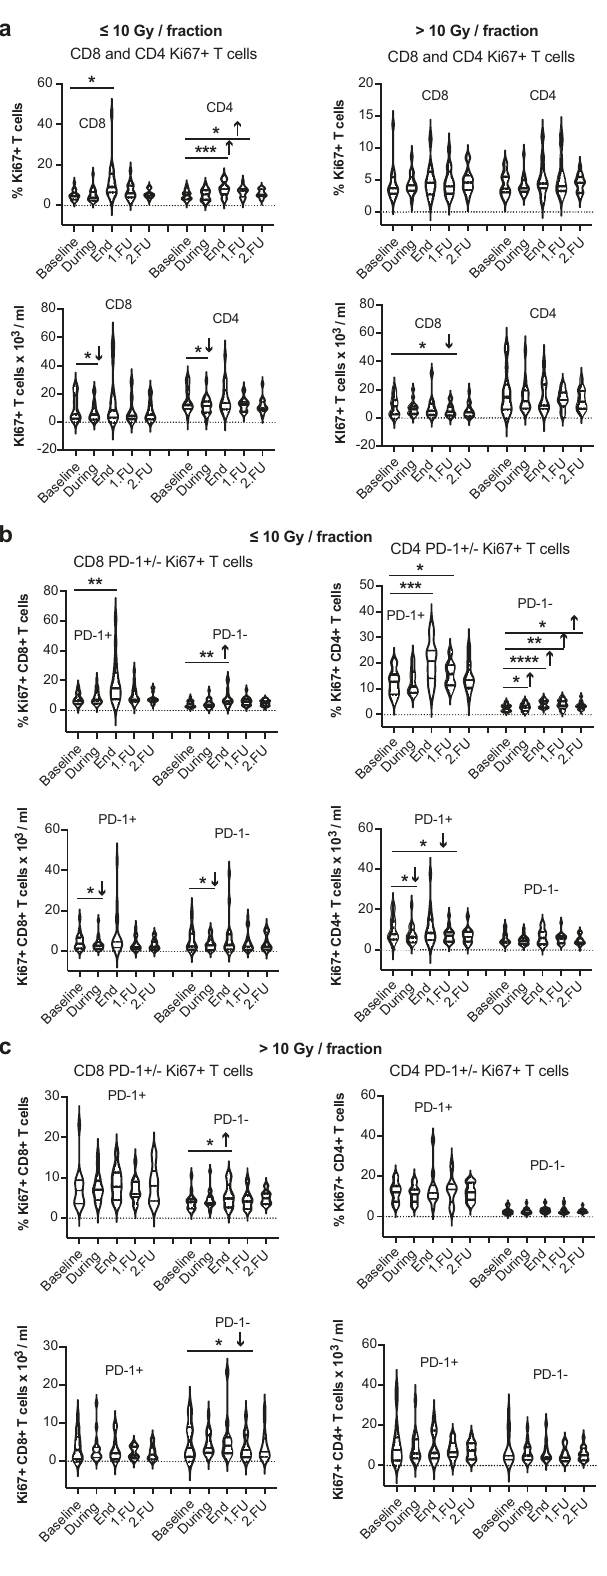
local progression with a regional and distant progression and received treatment (SBRT, chemotherapy, and ICB). Four patients developed distant metastases (8%) and later received RT or ICB, and three patients had regional and distant metastases (6%) and